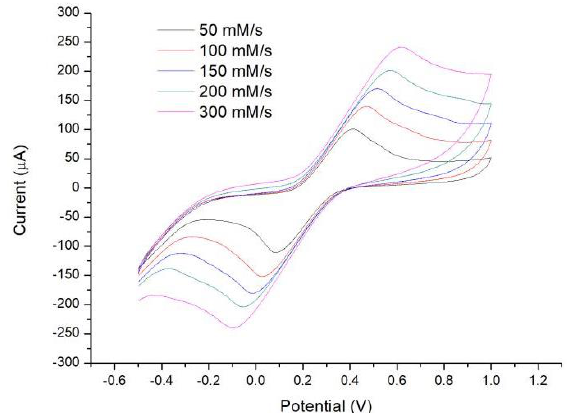
Figure 3. Measurement of cyclic voltammetry (CV) curves at scan rates of 50 mV/s, 100 mV/s, 150 mV/s, 200 mV/s, and 300 mV/s.